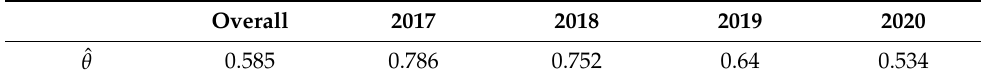
Table 3. Overall and yearly mark rate (ˆ θ